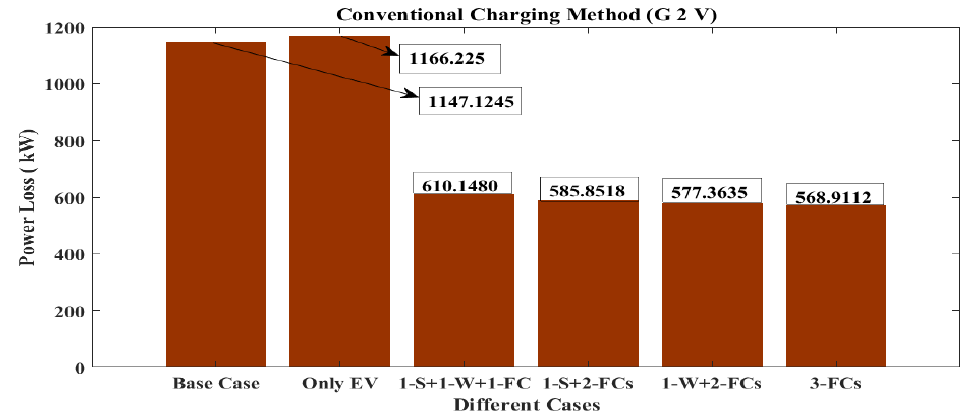
Figure 19. Conventional EV Charging method (G2V) P Loss with Different Cases. Table 8. Comparison of P Loss for different operating conditions.